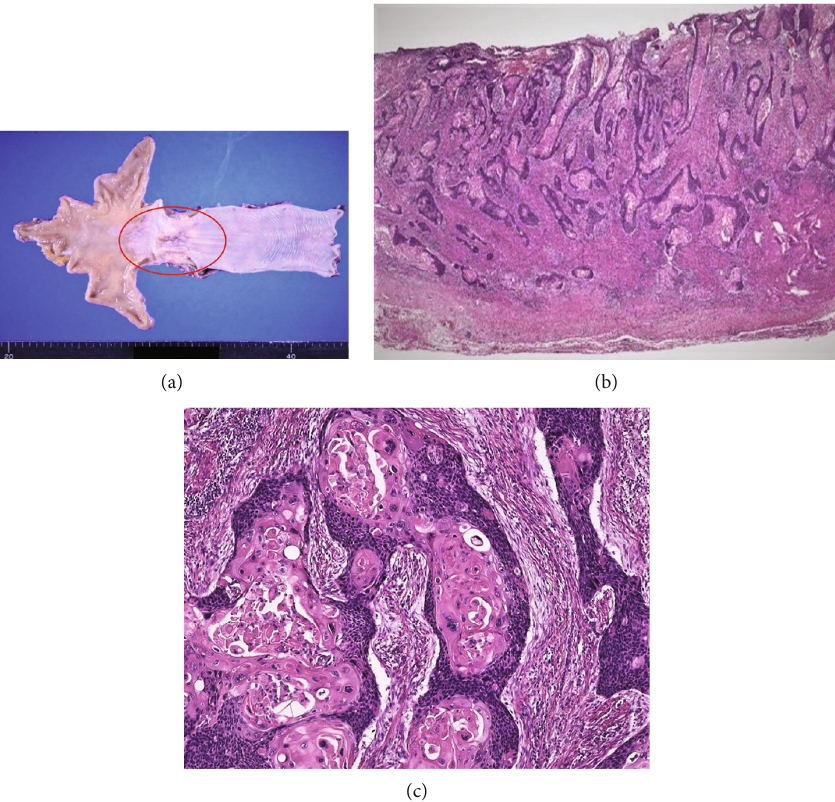
Figure 1: Primary esophageal carcinoma in the lower thoracic esophagus. (a) Gross appearance of the esophageal carcinoma. A 35 × 30 mm of ulcerative tumor in the lower third of the thoracic esophagus was seen. (b) Histologic fi nding. Hematoxylin and eosin (HE) staining showed well-di ff erentiated squamous cell carcinoma. (c) High magni fi cation view. Well-di ff erentiated carcinoma with large squamous pearls was